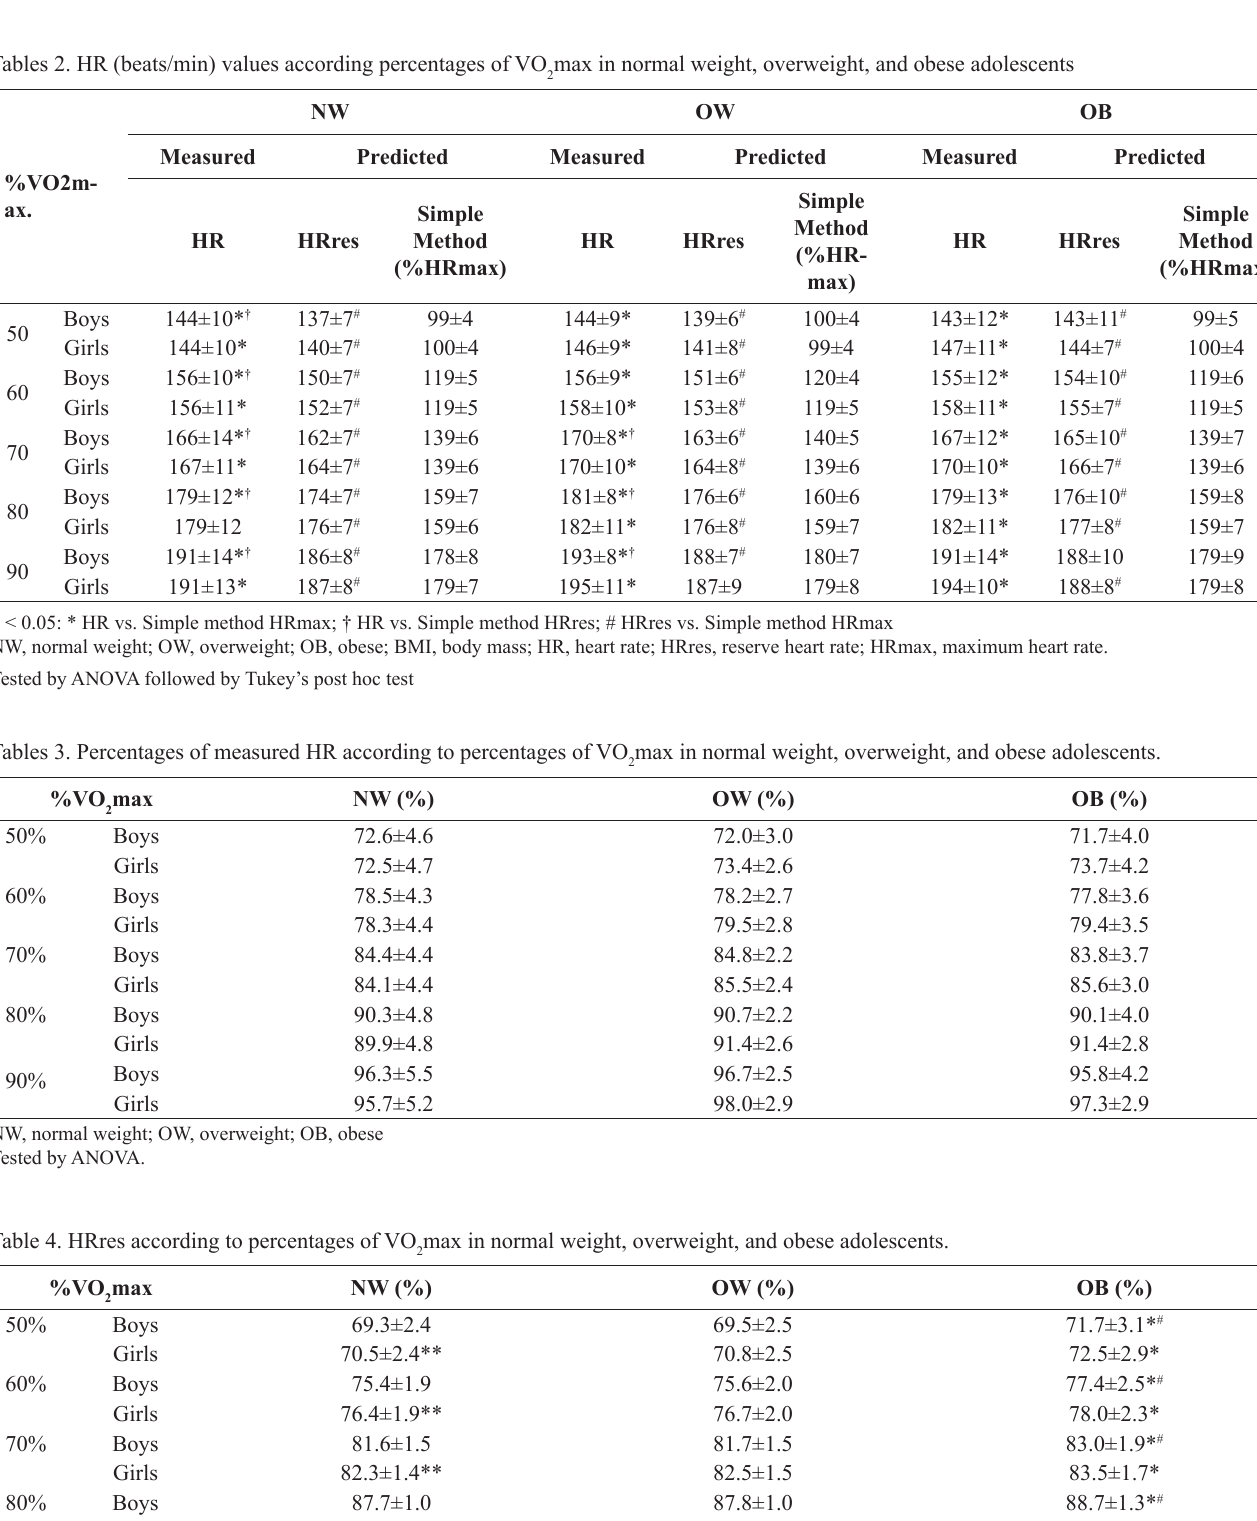
Tables 2. HR (beats/min) values according percentages of VO